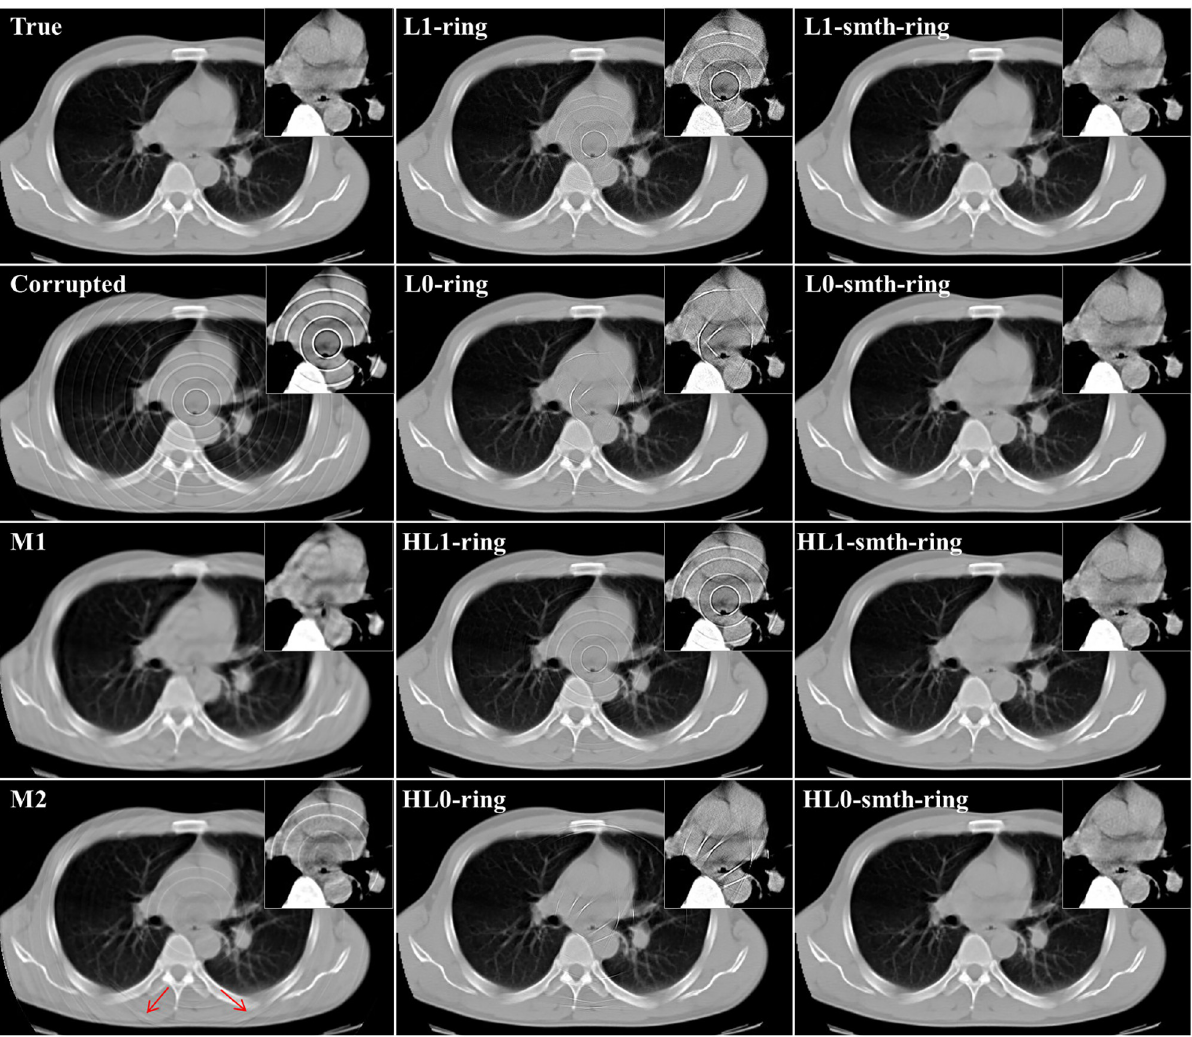
Fig 4. Reconstructed images in the second study case (noise-free, adjacent error detector bins, and angular-independent error